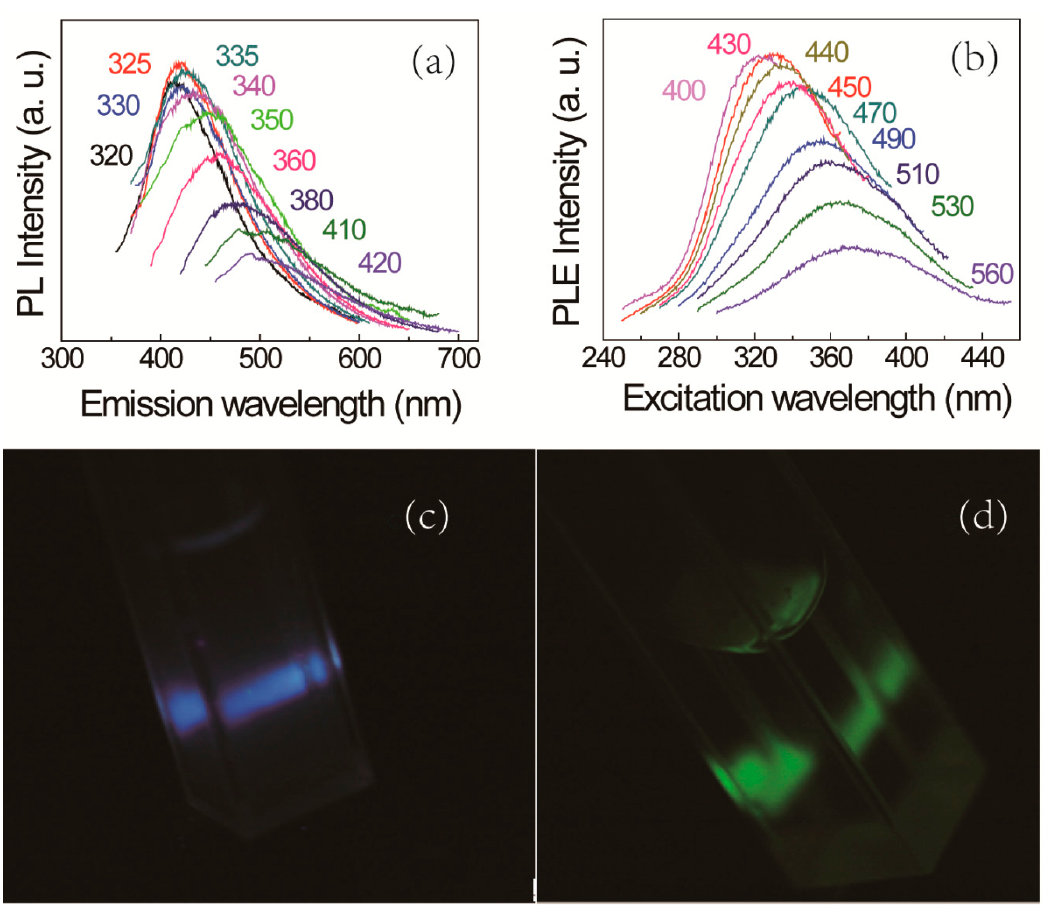
Figure 3. ( a ) PL spectra of silicon NCs colloid with pH value of 4; ( b ) PLE spectra of silicon NCs colloid with pH value of 4; ( c ) optical photograph obtained from silicon NC colloids excited at 360 nm, corresponding to blue (~450 nm); and ( d ) optical photograph from silicon NCs colloid excited at 420 nm, corresponding to green color (~510 nm).